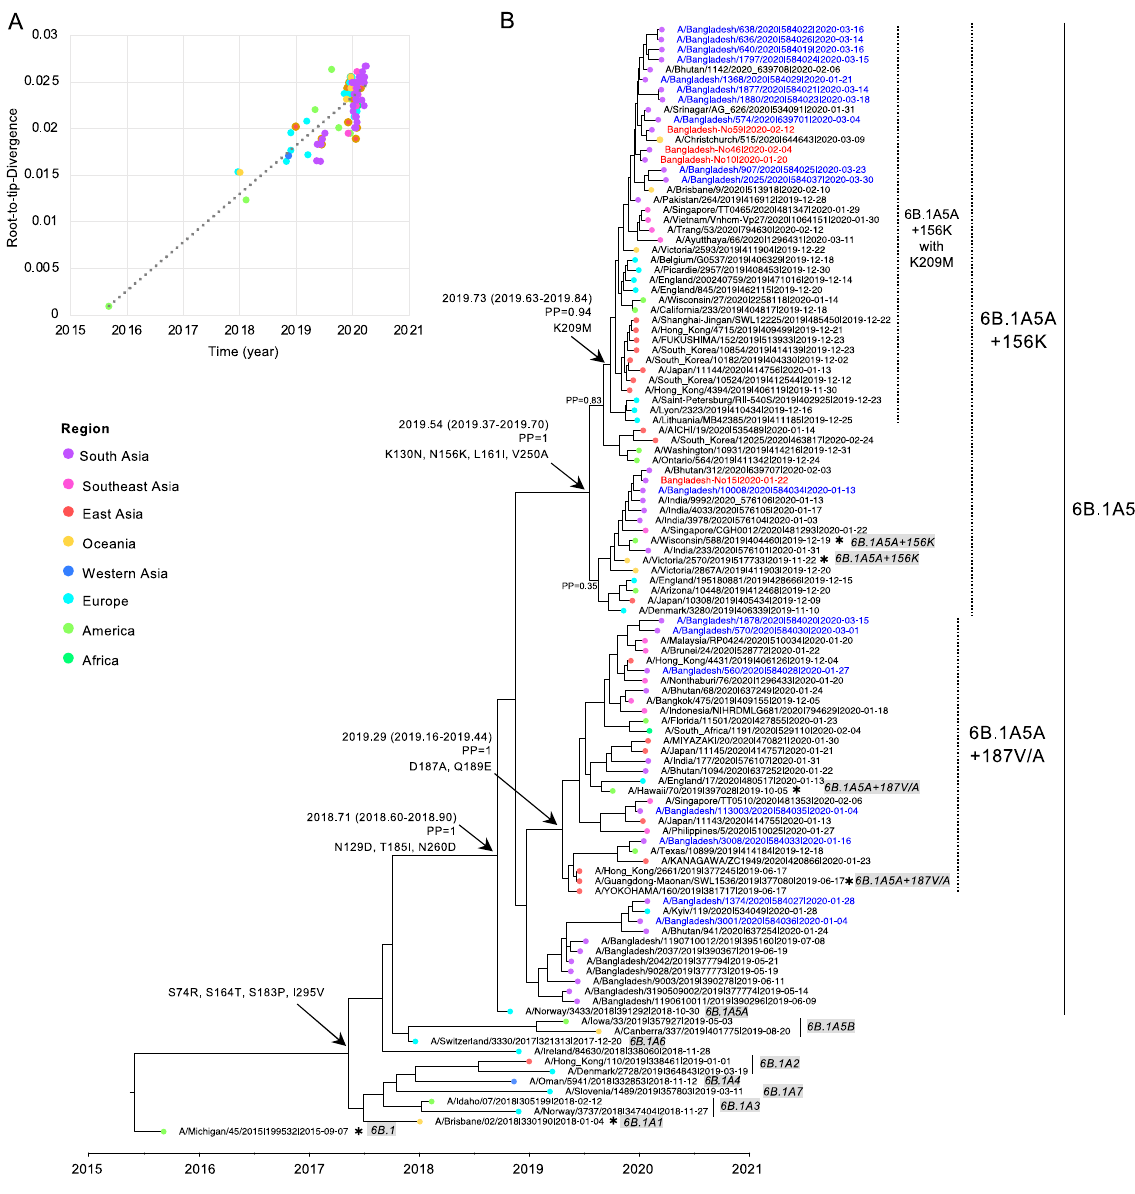
Figure 3. Evolution of Bangladesh H1N1pdm subclade 6B.1A5A strain 2020. ( A ) A root-to-tip analysis of the dataset. ( B ) The maximum clade credibility (MCC) tree based on the HA gene of H1N1pdm was estimated in BEAST package v1.10.4 with HKY + F + I, an exponential population growth model, and the relaxed molecular clock. The nucleotide sequences of the HA genes retrieved from EpiFlu GISAID are labeled as follows: isolate name|isolate ID|collection date (yyyy-mm-dd). The H1N1pdm strains, including the H1N1pdm subclade reference strains, are shown in black, with the clade name highlighted in gray at the end. Ranges of subclades 6B.1A1, 6B.1A2, 6B.1A3, 6B.1A4, 6B.1A5A, 6B.1A5B, 6B.1A6A, and 6B.1A7A are shown by vertical bars. Ranges of 6B.1A5A + 156K, 6B.1A5A + 187V/A, and 6B.1A5A + 156K with K209M are shown by vertical doted bars. Asterisks indicate the vaccine strains. The Bangladesh 2020 strains in EpiFlu and the newly obtained Bangladesh 2020 sequences in the present study are shown in blue and red, respectively. The regions in which the strains circulated are indicated at the branch tips and are color-coded as indicated in the legend on the left. The x-axis of the tree indicates the time (year). The tMRCA and interval, posterior probability (PP), and the occurrence of amino acid mutations of the key nodes are indicated by